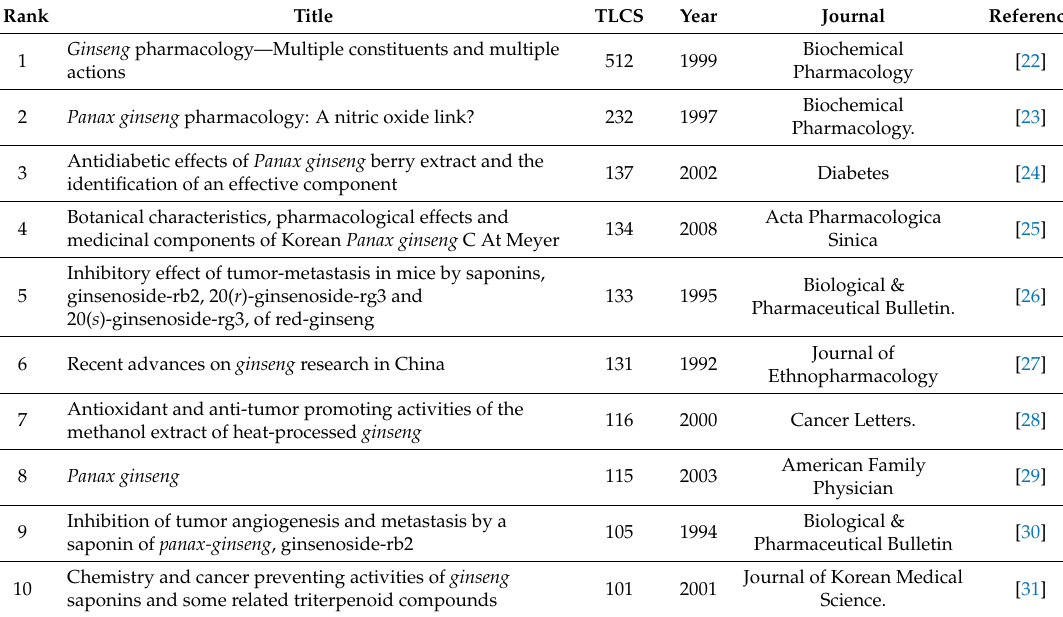
Table 5. Top-10 most cited